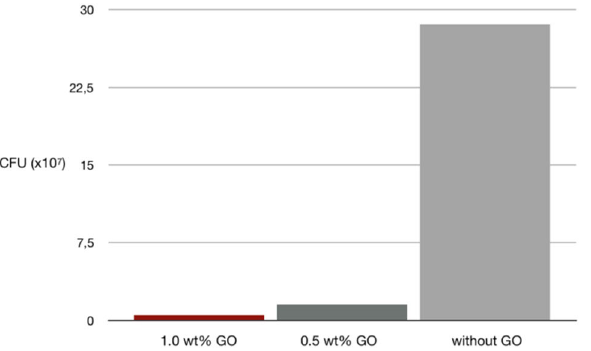
Figure 6. CFU counting evaluation of synthesized biomaterials with addition of 1.0 wt% GO, with the addition of 0.5 wt% GO, and without the addition of GO.